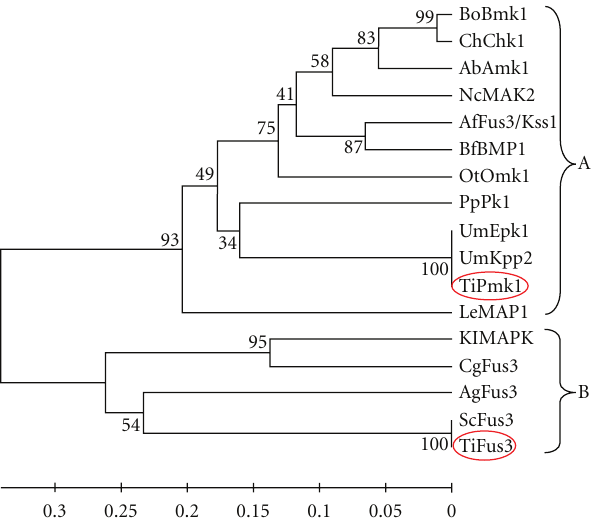
Figure 1: Phylogenetic analysis with TiFus3, TiPmk1, and selected fungal MAP kinases (GenBank accession numbers in parenthesis). Bipolaris oryzae, BoBmk1 (AB180104.1); Cochliobolus heterostrophus, ChChk1 (AF178977.1); Alternaria brassicicola, AbAmk1 (AY515257.1); Neurospora crassa, NcMAK2 (AF348490.1); Aspergillus flavus, AfFus3/Kss1 (XM002374886.1); Botryotinia fuckeliana, BfBMP1 (AF205375.1); Olpitrichum tenellum, OtOmk1 (EU479712.1); Postia placenta, PpPk1 (XM002471663.1); Ustilago maydis, UmEpk1 (XM754359.1), UmKpp2 (AF193614.1); Tilletia indica, TiPmk1 (FJ571362.1), TiFus3 (HQ268553); Lentinula edodes, LeMAP1 (AB446447); Kluyveromyces lactis, KlMAPK (XM454426.1); Candida glabrata, CgFus3 (XM447892.1); Ashbya goesypii AgFus3 (NM210920.1); Saccharomyces cerevisiae ScFus3 (NM001178256.1). The phylogram was constructed by UPGMA method of MEGA version 4.0.02. Bootstrap values are indicated against each